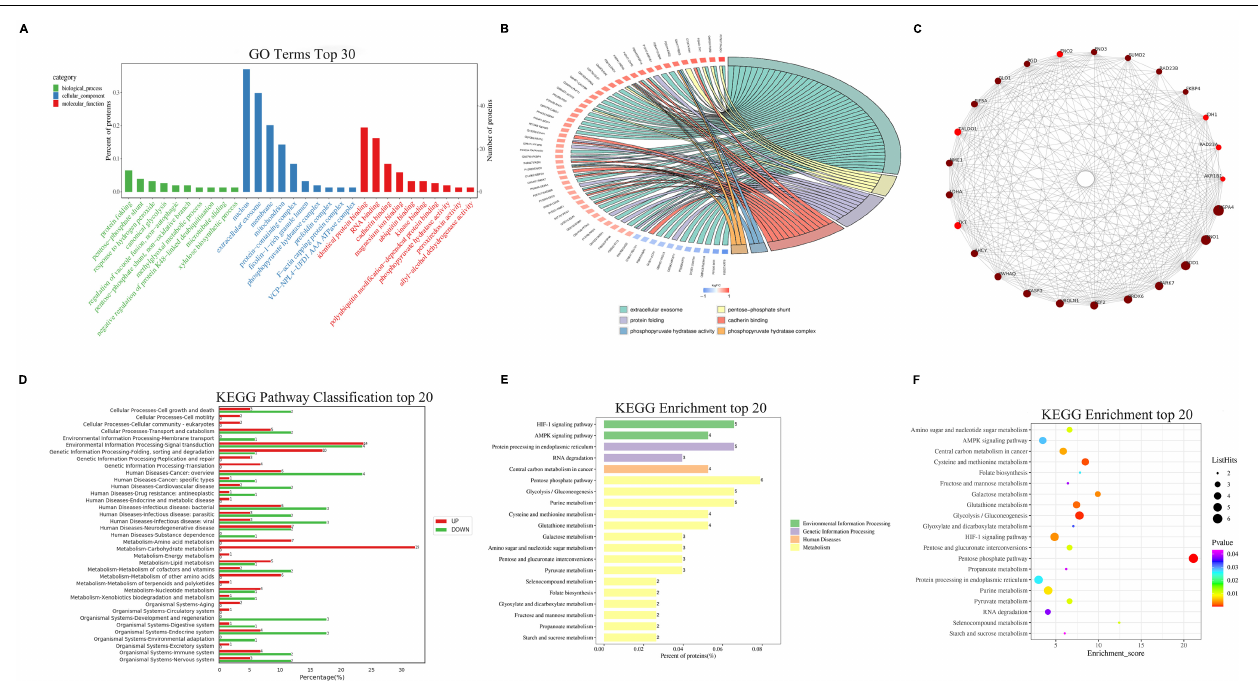
FIGURE 8 | TMT quantitative proteomic analysis. The differentially expressed proteins were divided into three categories by GO analysis, and each category was divided into multiple items. Then top 10 differential proteins in each category were mapped (A) . (B) GO enrichment chord graph. Red on the left indicates upregulated proteins while blue downregulated proteins. The right represents the GO corresponding items. (C) PPI network analysis. Twenty-five proteins with the highest connectivity were selected to draw the interaction network diagram. (D) KEGG pathway classification. The percentage of differentially expressed proteins in pathways and metabolism is indicated. (E,F) Top 20 pathways and metabolisms with the highest enrichment scores in KEGG enrichment